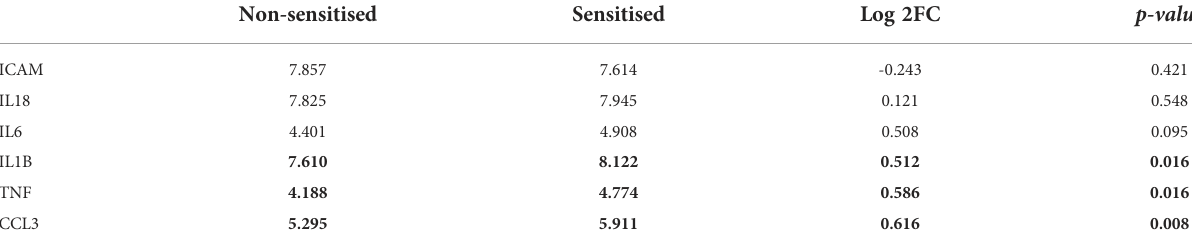
Values in bold indicate statistically signi fi cant differences between the sensitised rats and non-sensitised controls (p <